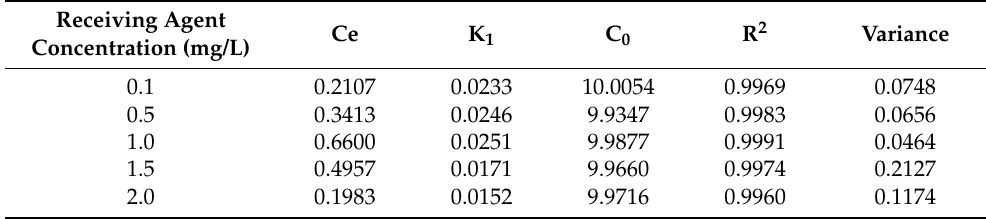
Table 7. The calculated numerical parameter values of the PFO models for the W3 membrane removal process with different receiving agent